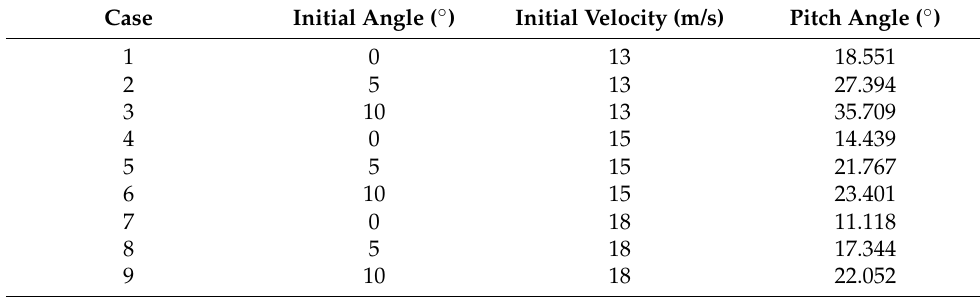
Table 3. Pitch angle of vehicle.